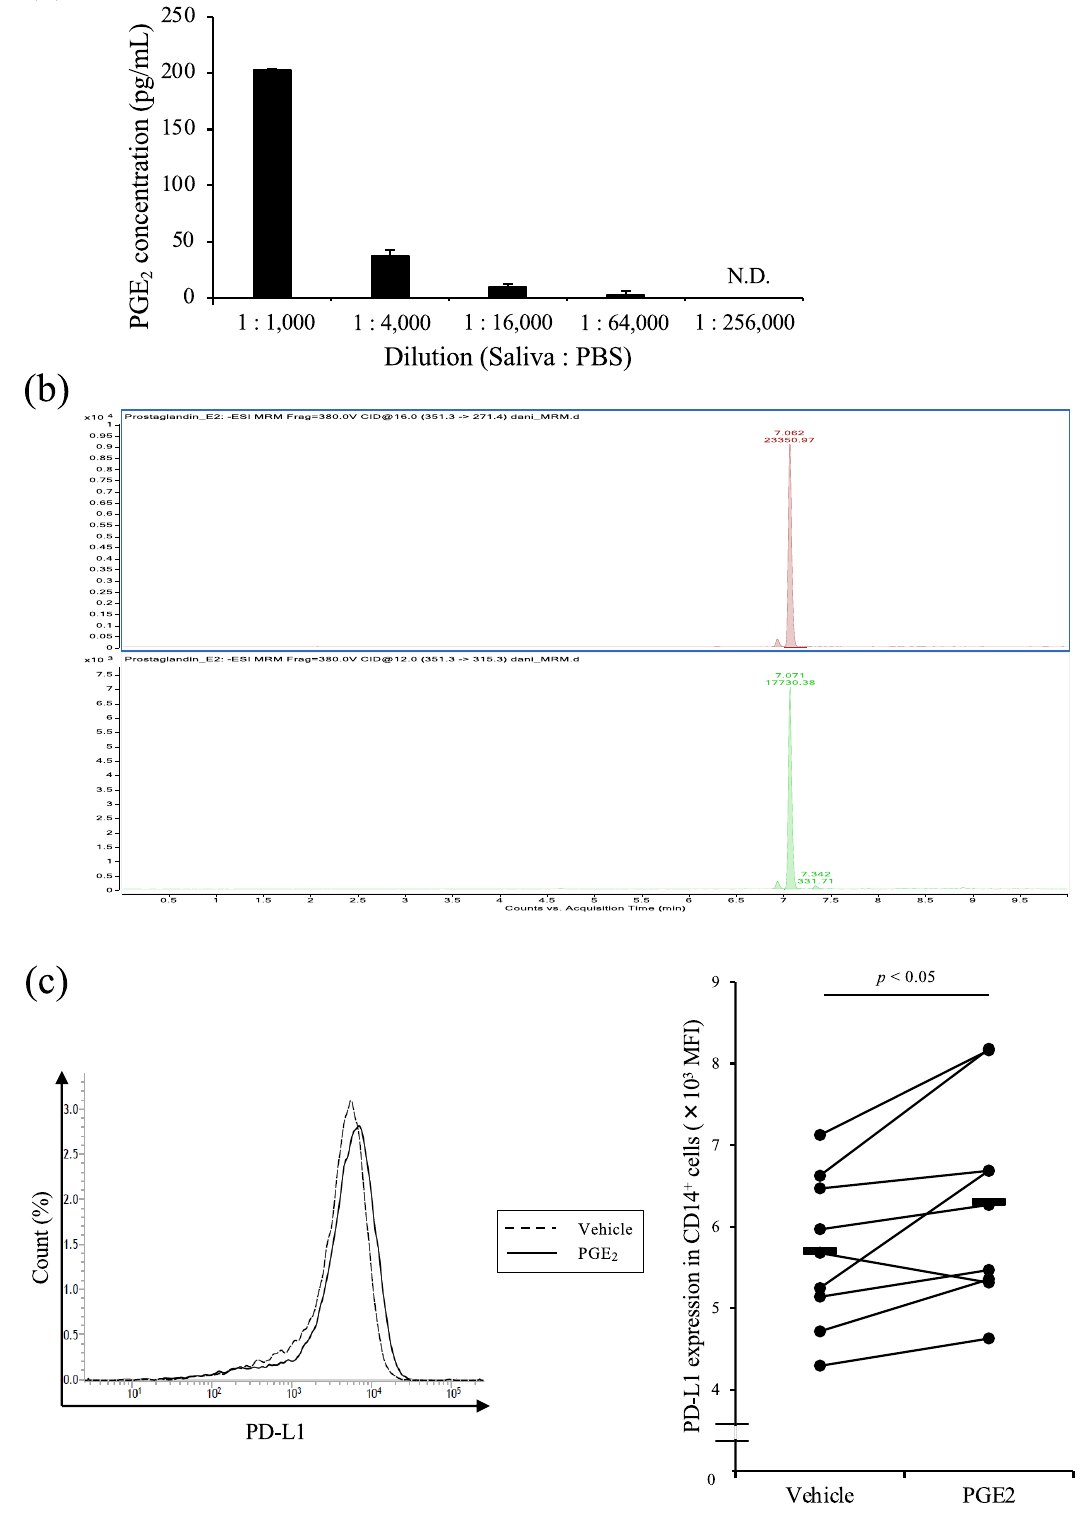
Figure 3. The presence of PGE 2 in Rm-saliva. ( a ) PGE 2 concentration of Rm-saliva was measured by ELISA. ( b ) The purification of PGE 2 from Rm-saliva was conducted by SPE combined with fractionation using HPLC. ( c ) CD14 + cells were cultured with PGE 2 , and PD-L1 expression was measured by flow cytometry. Statistical difference was identified by the Wilcoxon signed-rank test. N.D. not